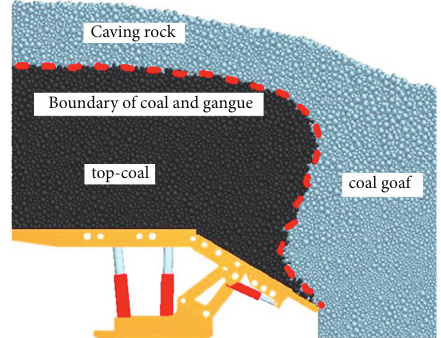
Figure 2: Result image of the coal gangue boundary.